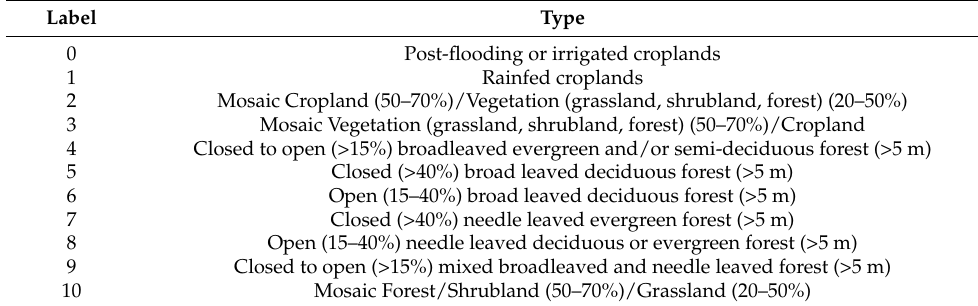
Table 2. The description of the earth surface type